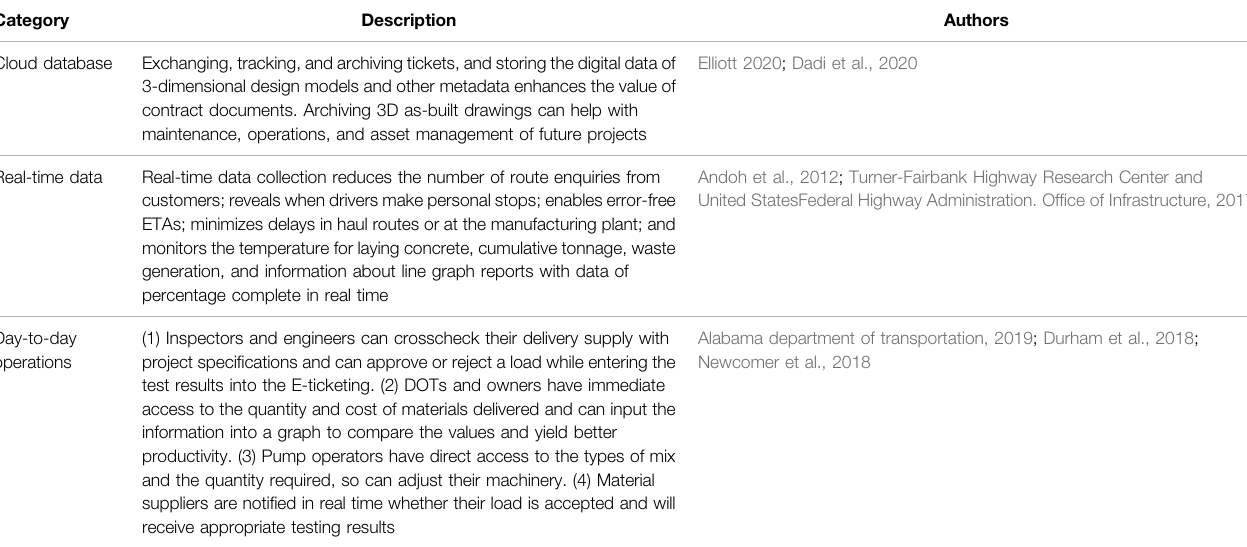
TABLE 5 | Bene fi ts of E-ticketing for